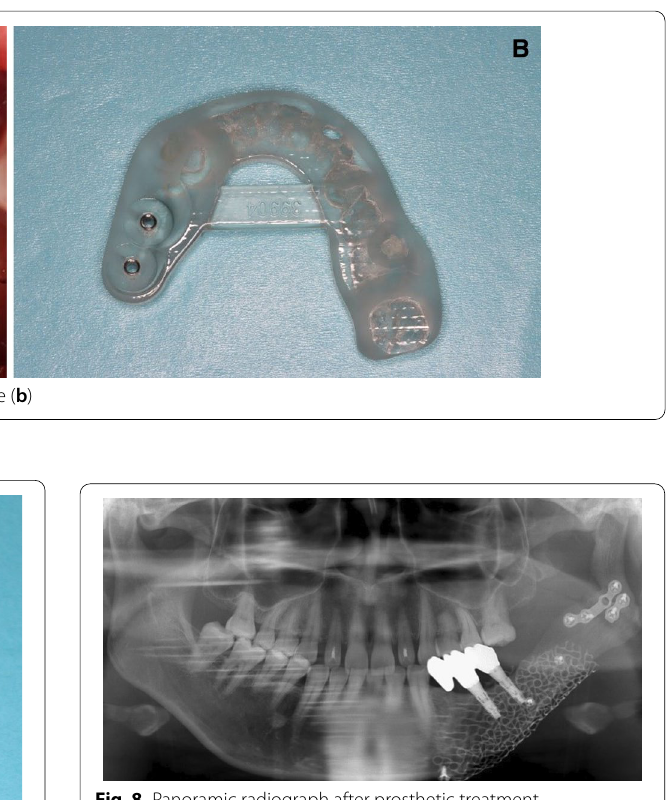
Fig. 8 Panoramic radiograph after prosthetic treatment